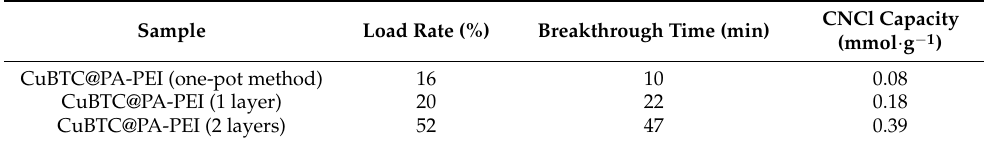
Table 2. Load rate and elimination abilities of